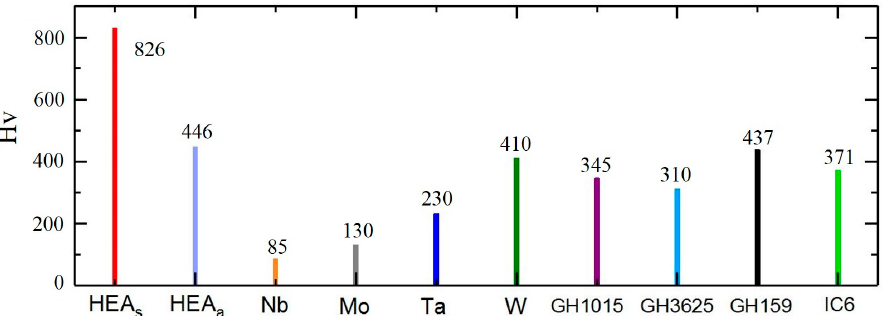
Figure 7. Microhardness (on XY plane) comparison for various pure metals and alloys